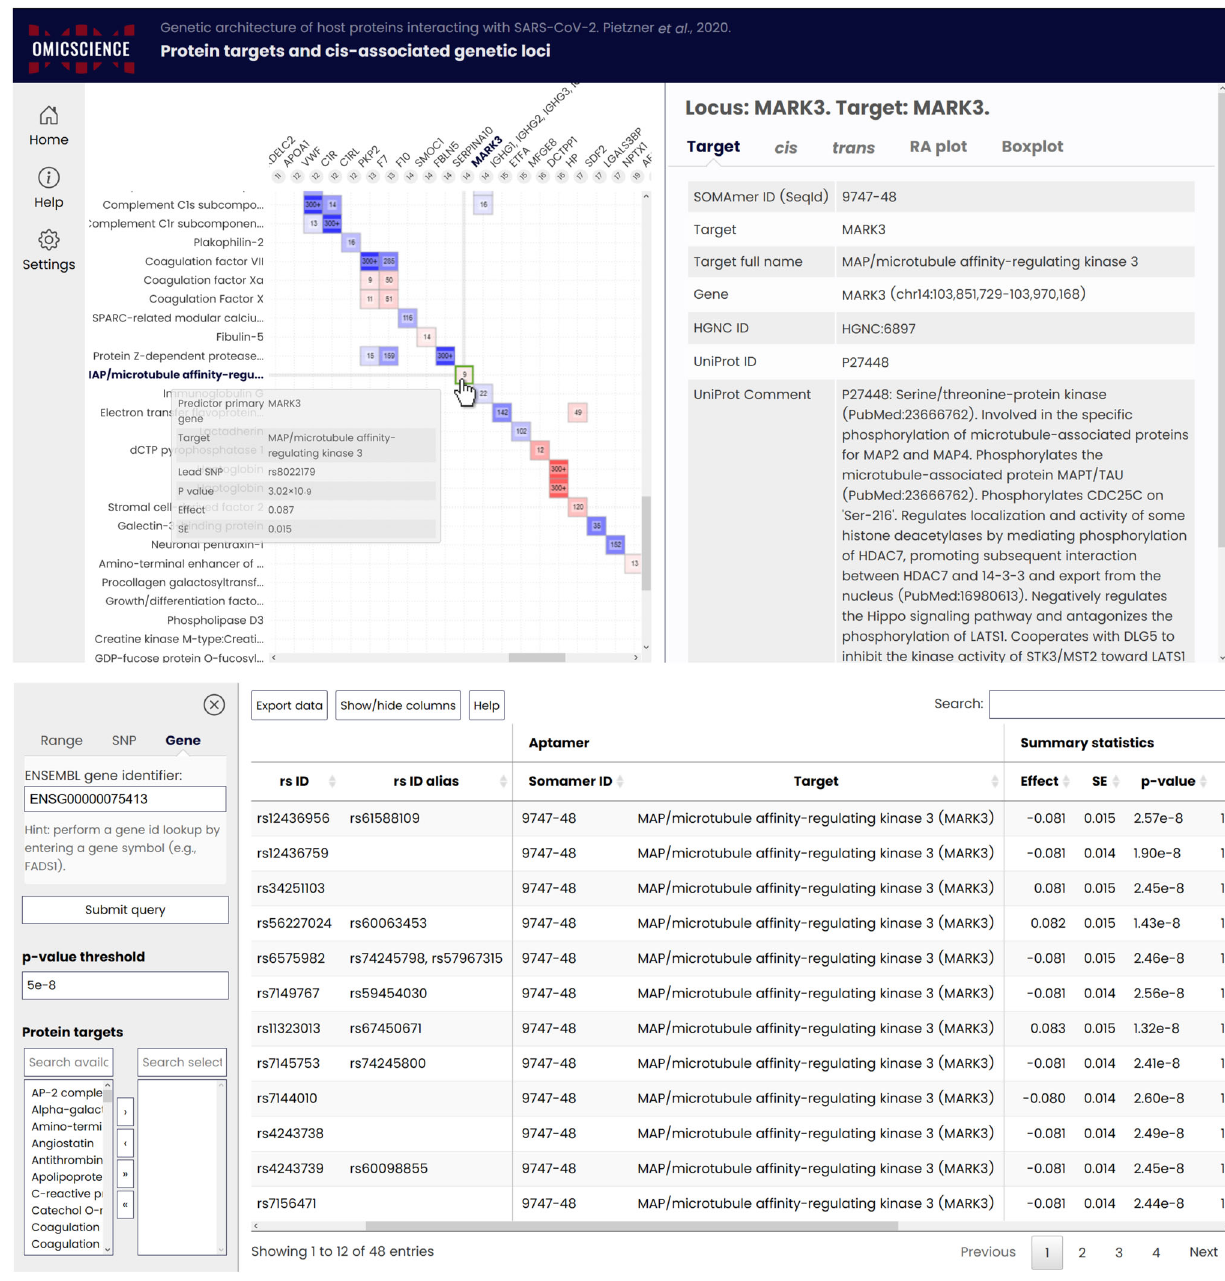
Fig. 7 Screenshots from the webserver. Upper panel: The matrix shows p -values and beta estimates from linear regression models for independently associated single nucleotide polymorphisms (SNPs) at a given locus across protein targets. The matrix can be customized to include only targets of interest or based on statistical criteria. Hovering above fi lled boxes shows information about the SNP and the associated target. The right-hand side shows information about the target, including associated SNPs in cis and trans , and includes regional associations (RA) plots as well as boxplots for plasma levels of the protein target across each SNP. We chose MAP/microtubule af fi nity-regulating kinase 3 (MARK3) as an example. Lower panel: Query options for variant-, gene-, or region-based queries of SNP associations across all Exclusion criteria were: clinically diagnosed diabetes mellitus, inability to walk unaided, terminal illness, clinically diagnosed psychotic disorder, pregnancy, or lac- tation. The study was approved by the Cambridge Local Research Ethics Committee (NRES Committee - East of England, Cambridge Central, ref. 04/Q0108/19) and all participants provided written informed consent. Fenland participants were on average 48.6 years old (standard deviation: 7.5 years) and 53.4% were female. Mapping of protein targets across platforms . We mapped each candidate protein to its UniProt-ID 42 and used those to select mapping aptamers and Olink measures based on annotation fi les provided by the vendors.